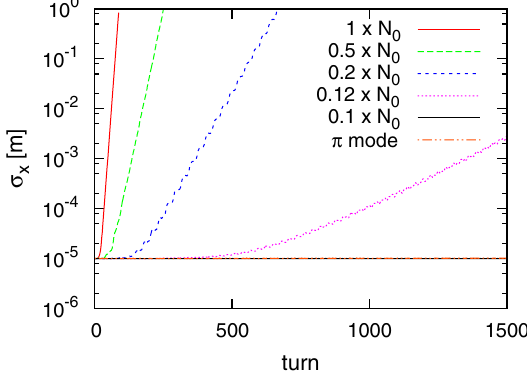
FIG. 7. Evolution of beam size for the single beam tracking simulation in FCCee-Z. Assuming the σ mode, ξ ξ ¼ 0 . 0025 ð N ð(cid:2)Þ ¼ 10 10 Þ − 0 . 025 ð 10 11 Þ in θ x ¼ 0 . 018 . The last line is given for the π mode at and ν z ξ ¼ 0 . 025 . x